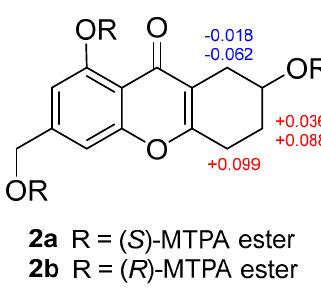
Figure 4. Δδ ( δ S − δ R ) values in ppm for MTPA eaters of 2 . Figure 4. ∆ δ ( δ − δ S R ) values in ppm for MTPA eaters of 2